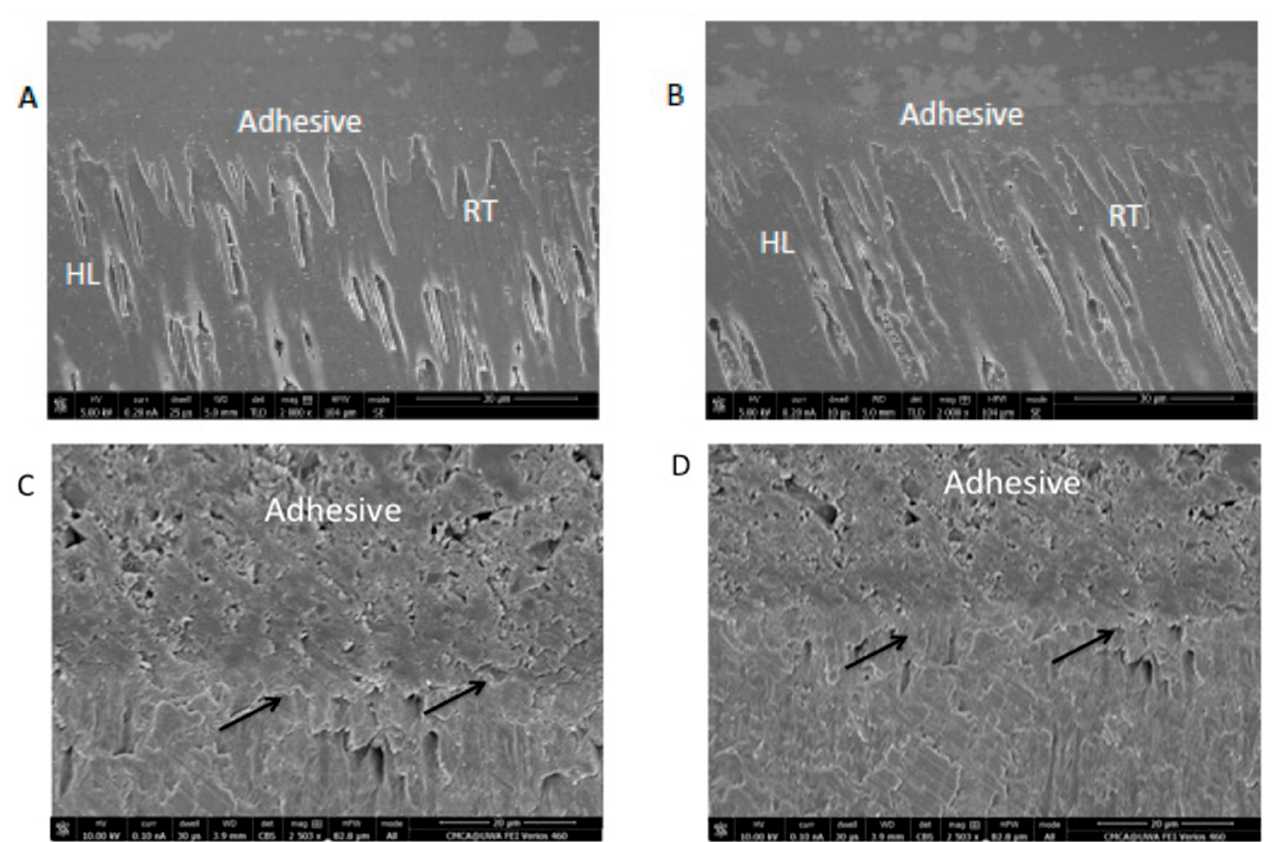
Figure 2. EDX element mapping evaluation of the HA nanoparticles. The two figures show evidence of calcium ( CA ), and phosphorus ( P ) in the samples.